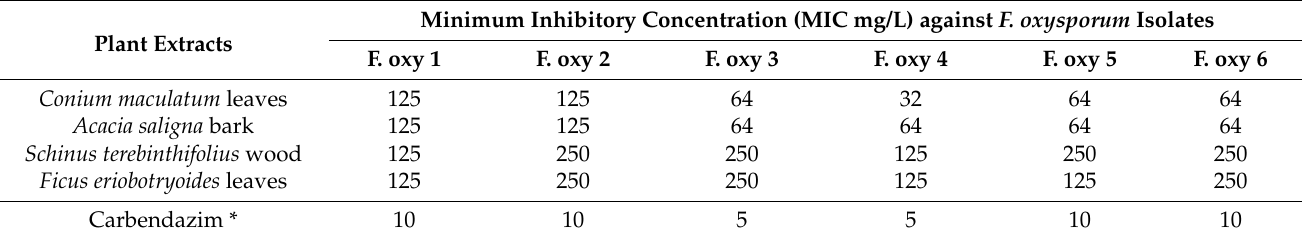
Table 3. Minimum inhibitory concentrations (MICs) of the plant extracts and reference